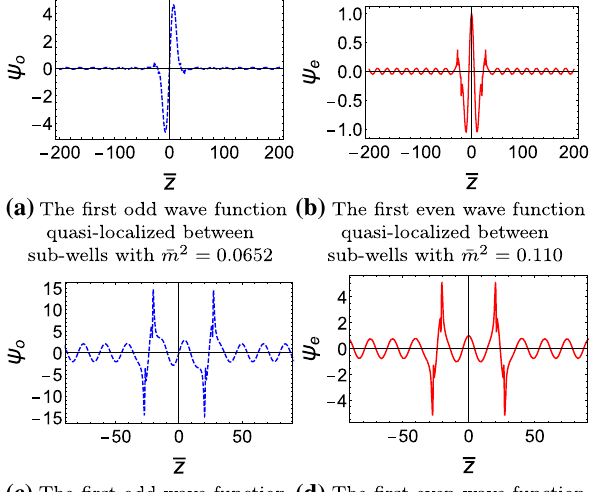
Fig. 22 Resonances quasi-localized between sub-wells and in sub- wells with ¯ b = 13, ¯ d = 2 . 3, and ¯ α = − 0 . 189 for case 3